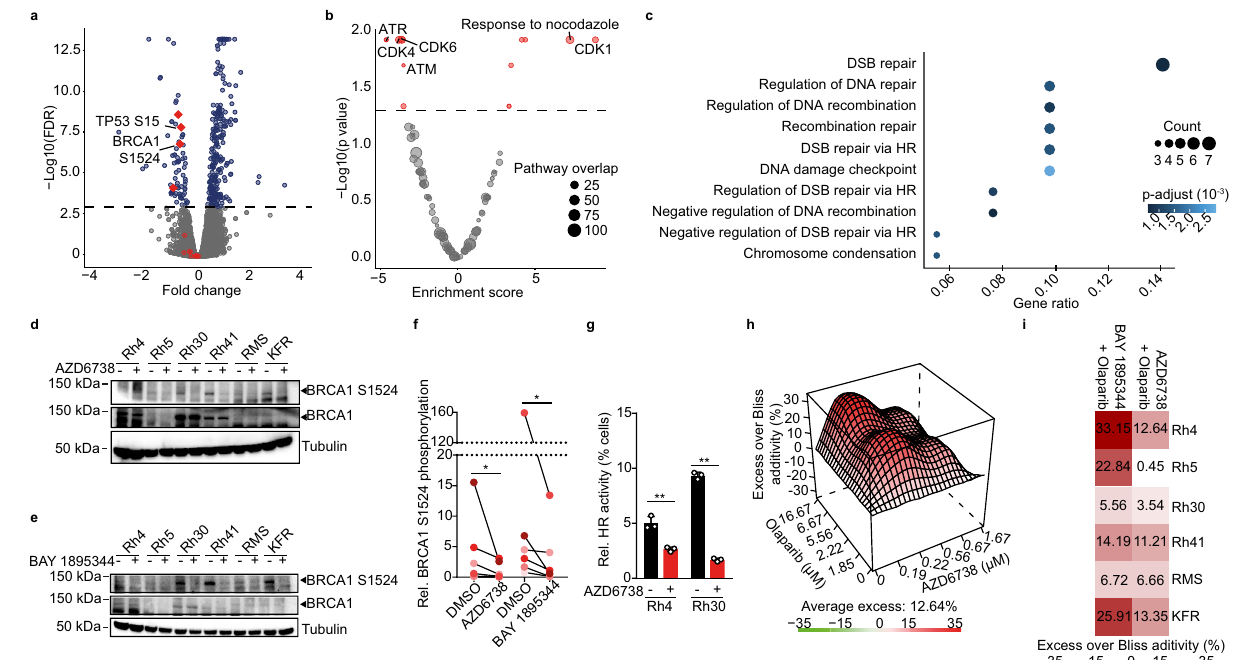
Fig. 3 | Pharmacological ATR inhibition has on-target activity and leads to reduced BRCA1 activation and repressed homologous recombination. a Volcano plot showing relative changes in phospho-peptide abundance in PAX3- FOXO1-expressing Rh30 cells after 2h of incubation with AZD6738 (750nM) measured using LC-MS/MS proteomics (red, known ATR targets; dotted line indi- cating a false discovery rate (FDR) of 0.001). b Volcano plot showing relative enrichment of molecular pathways in which differential phospho-peptide abun- dance was observed in cells treated with AZD6738 (750nM) compared to DMSO- treated cells (dotted line indicating a false discovery rate of 0.05). c Cellular pro- cessessigni fi cantlyenrichedindifferentiallyabundantphospho-peptides.Western immunoblottingofBRCA1S1524andtotalBRCA1insixFP-RMScellsafter2hoursof